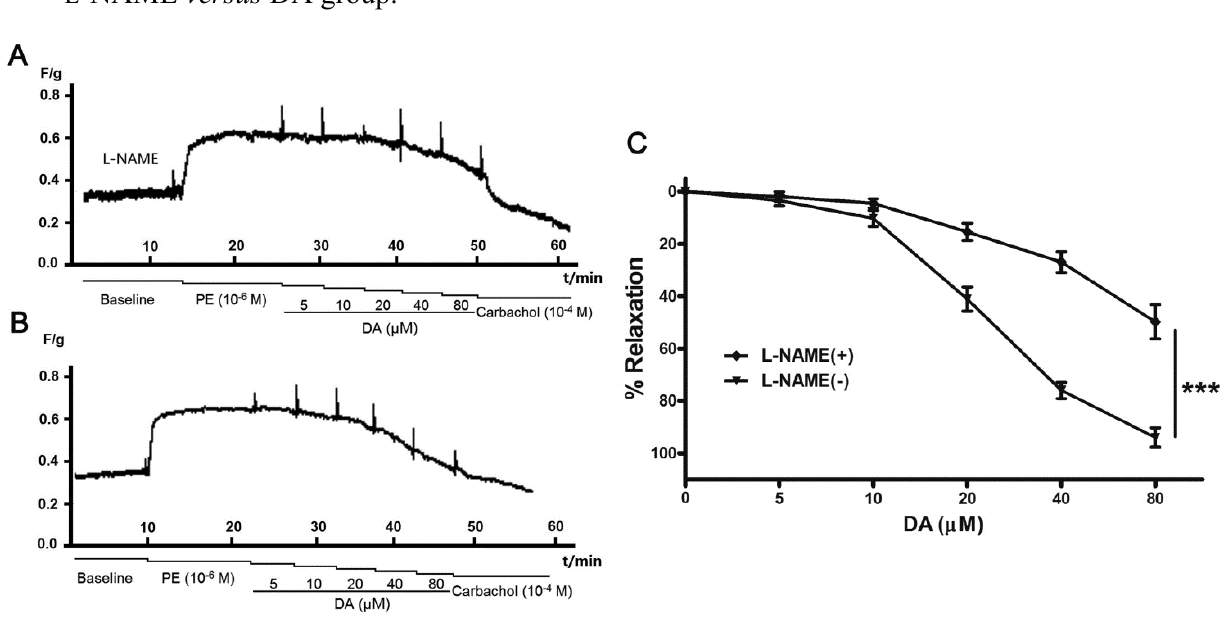
Figure 5. Effect of NO in DA-induced pulmonary artery rings relaxation. L -NAME (10 − 4 M) significantly reduced DA-induced dilation effect on endothelium-intact artery rings ( A , B ). Results were expressed as mean ± SEM ( n = 5) ( C ), *** p < 0.01 for inhibitory effect of L -NAME versus DA